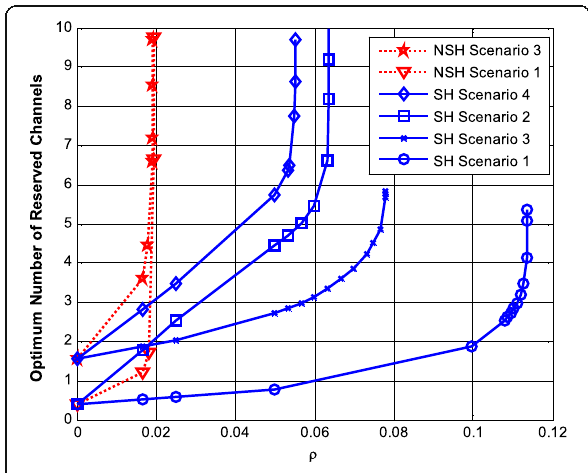
Fig. 9 Optimum number of reserved channels to achieve the Erlang capacity is shown in Fig. 8, as a function of the utilization factor of the primary channels for the scenarios described in Table 6. Both spectrum handoff and non-spectrum handoff are considered for scenarios 1 and